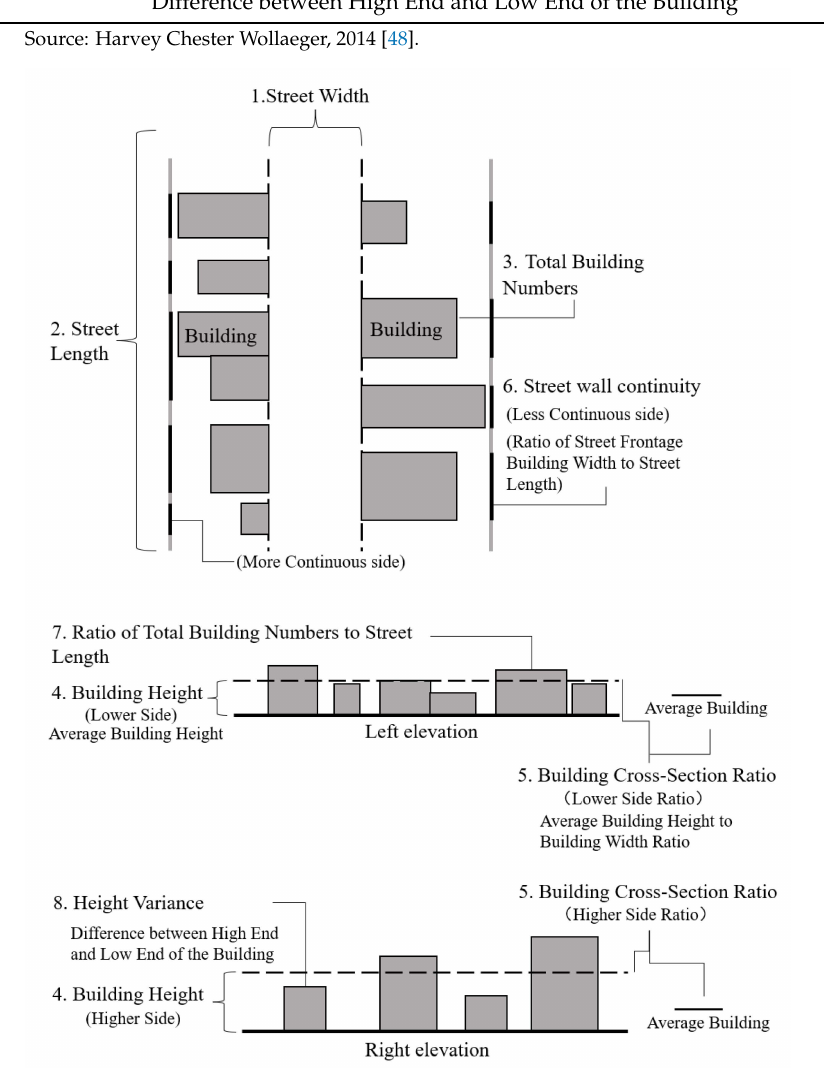
Figure 2. Quantitative street space indicator interpretation map